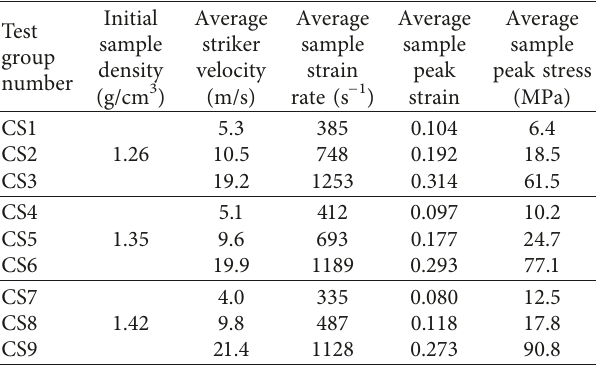
Table 1: Experimental results of calcareous sand.